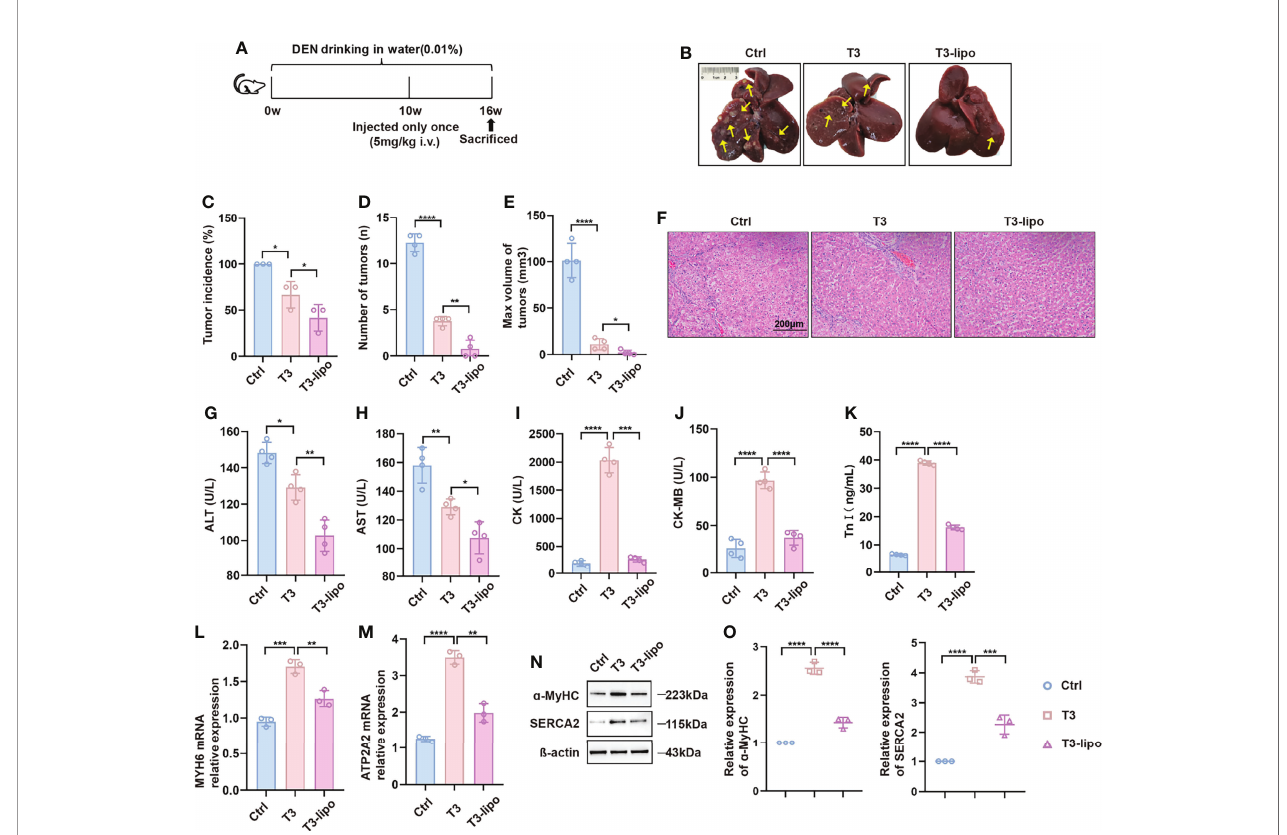
FIGURE 2 | T3-lipo inhibits hepatocarcinogenesis with reduced cardiotoxicity in DEN-induced primary HCC rat models. (A) Experimental design. (B) Representative upper and visceral views of livers from rats treated with saline, T3, and T3-lipo at a dose of 5 mg/kg via the tail vein. (C) Tumor incidence (%). (D) Number of tumors (n). (E) Max volume of tumors (mm³). V(mm 3 ) = a × b 2 /2 (a, the longest diameters; b, the shortest diameters). (F) H&E staining of liver tissues. (G) Serum levels of ALT(U/L). (H) Serum levels of AST(U/L). (I) Serum levels of CK(U/L). (J) Serum levels of CK-MB(U/L). (K) Serum levels of Tn-I (ng/ml). n = 4 rats per group.